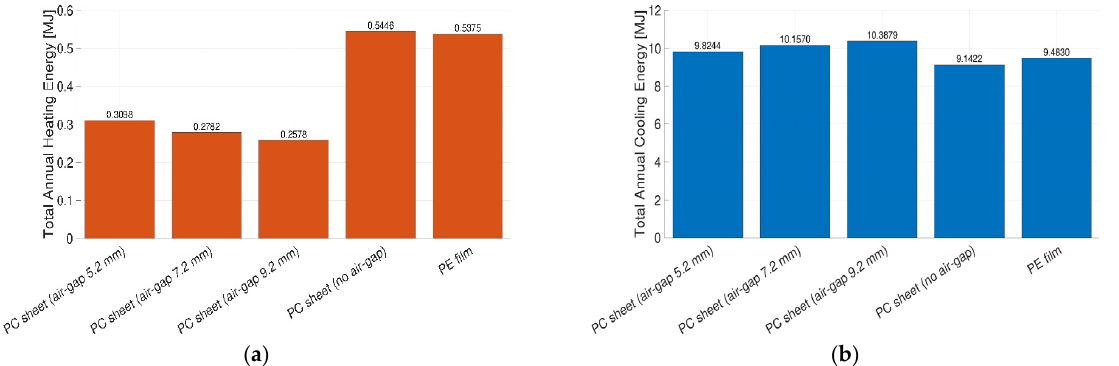
Figure 7. Ideal annual energy required for ( a ) heating and ( b ) cooling for the different glazing materials (using North-South orientation with an Even-Span shape).